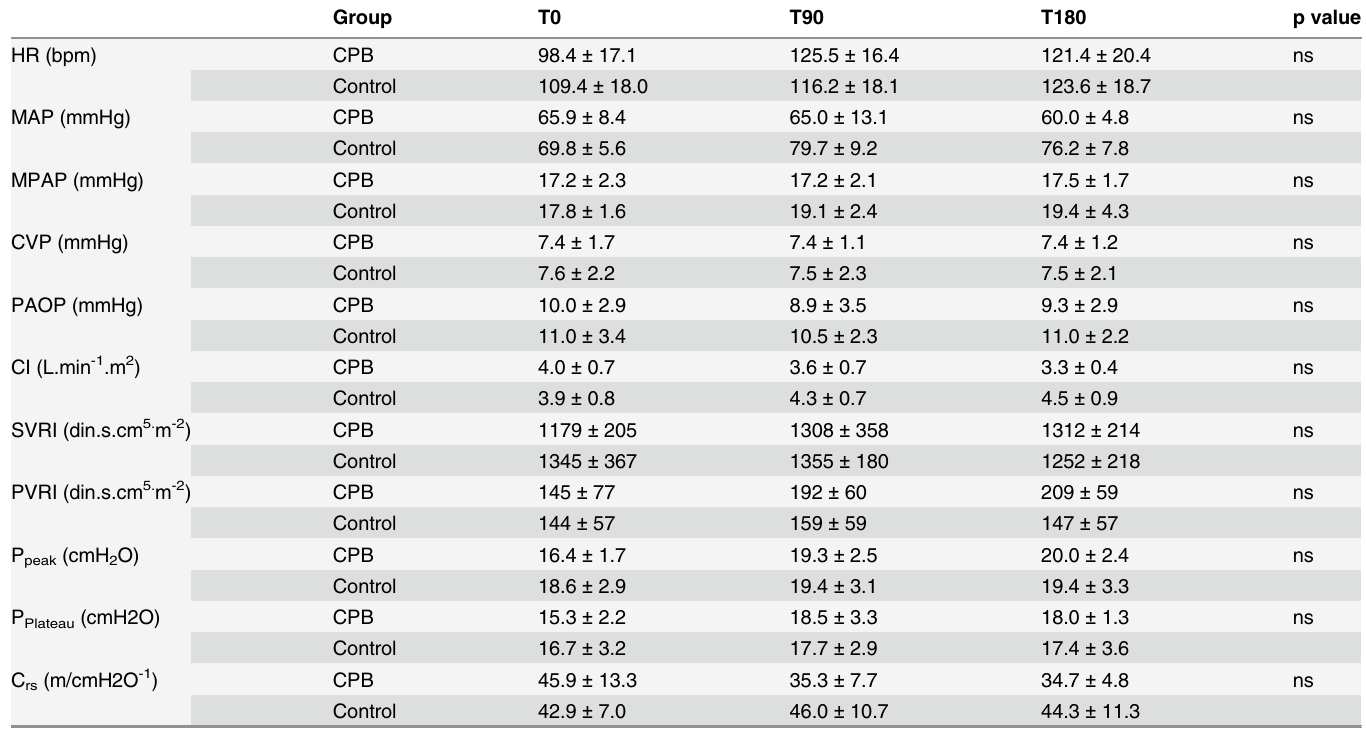
Table 2. Hemodynamic and mechanical respiratory behavior of the control and CPB groups throughout the